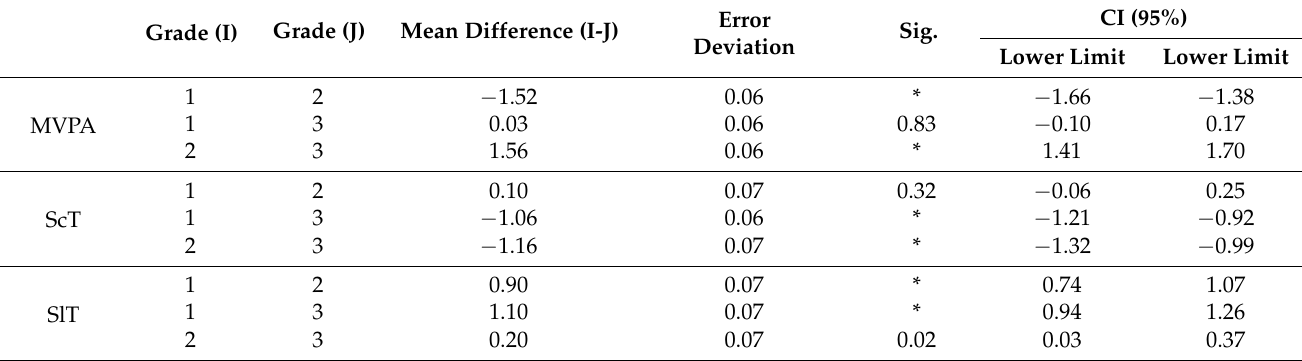
Table 6. Post-hoc multiple comparisons of variables in clusters.